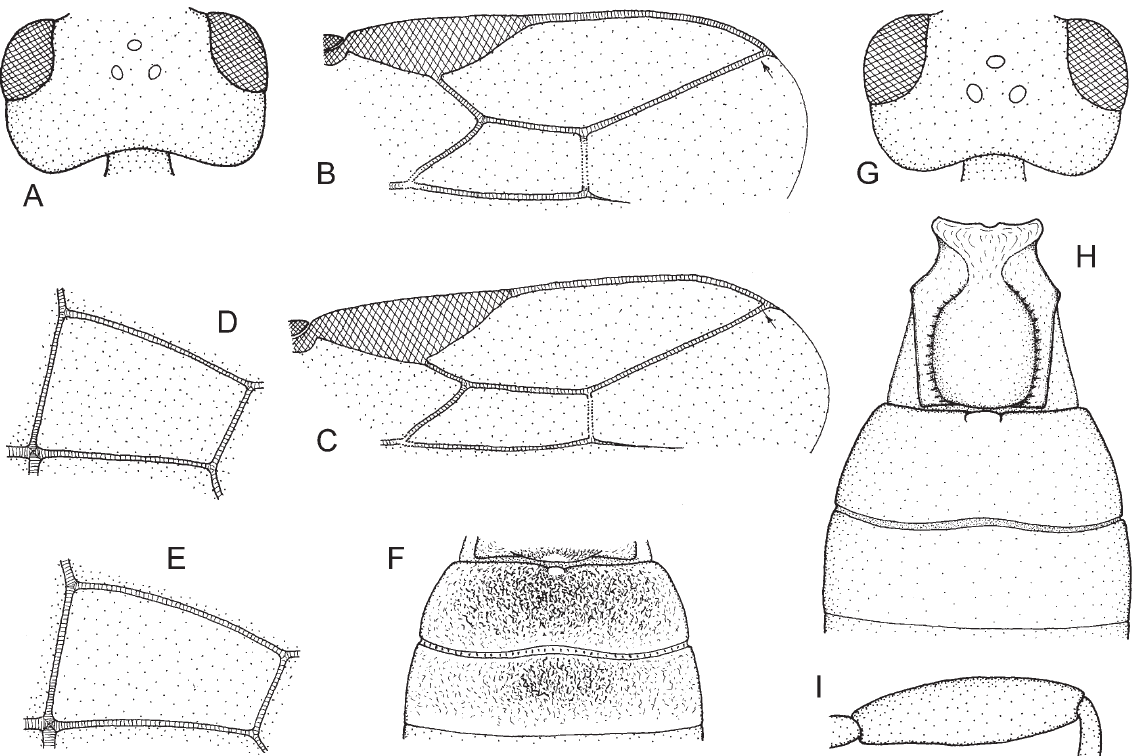
Fig. 29. — A-F . Bracon ( Glabrobracon ) nigriventris Wesmael, 1838 (A-B, D-E: ♀, C, F: ♂). A . Head in dorsal view. B-C . Distal part of right forewing. D-E . First discal cell of right forewing. F . Tergites 2-3. — G-I . Bracon ( Glabrobracon ) conjugellae Bengtsson, 1924, ♀ paralectotype. G . Head in dorsal view. H . Tergites 1-3. I . Hind